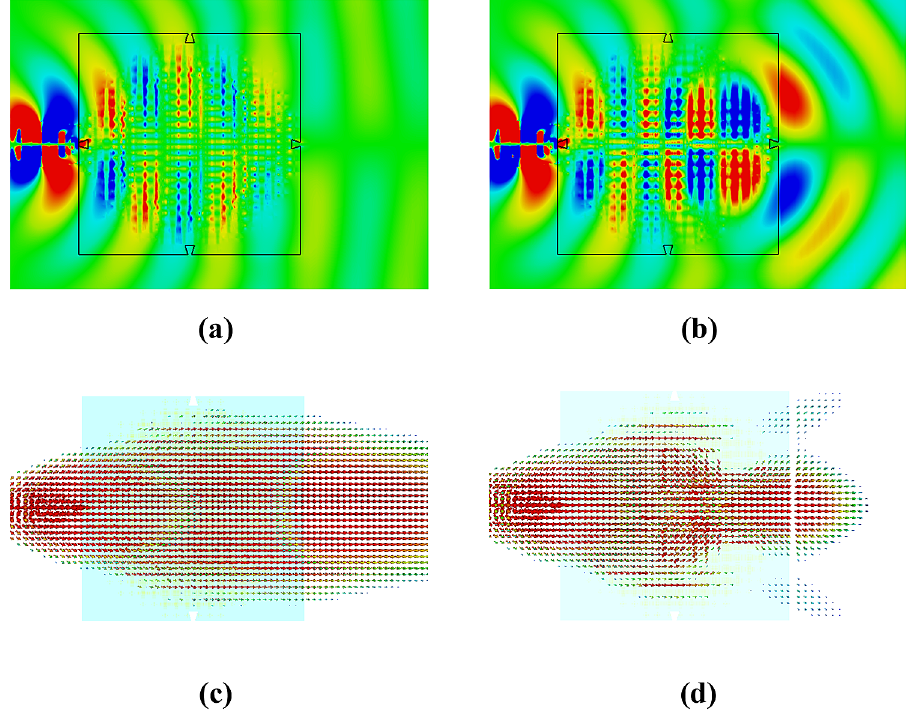
Figure 15. Simulated cross-polarized distributions of near electric-field regarding the bifunctional metalens on xoy -plane at 6 GHz. ( a ) The cross-polarized electric-field component ( E y ) of Luneburg lens. ( b ) The cross-polarized electric-field component ( E x ) of Maxwell fisheye lens. ( c ) Power-density distribution when illuminating from y axis (Luneburg lens). ( d ) Power-density of distribution when illuminating from x axis (fisheye